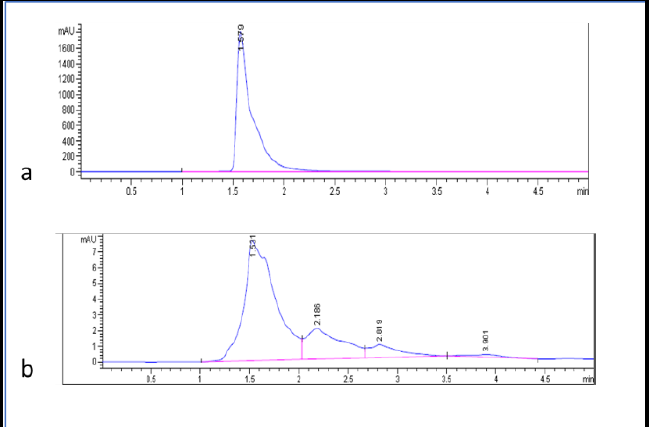
Figure 5. HPLC chromatogram ( a ) ascorbic acid standard and ( b ) ascorbic acid from fruit